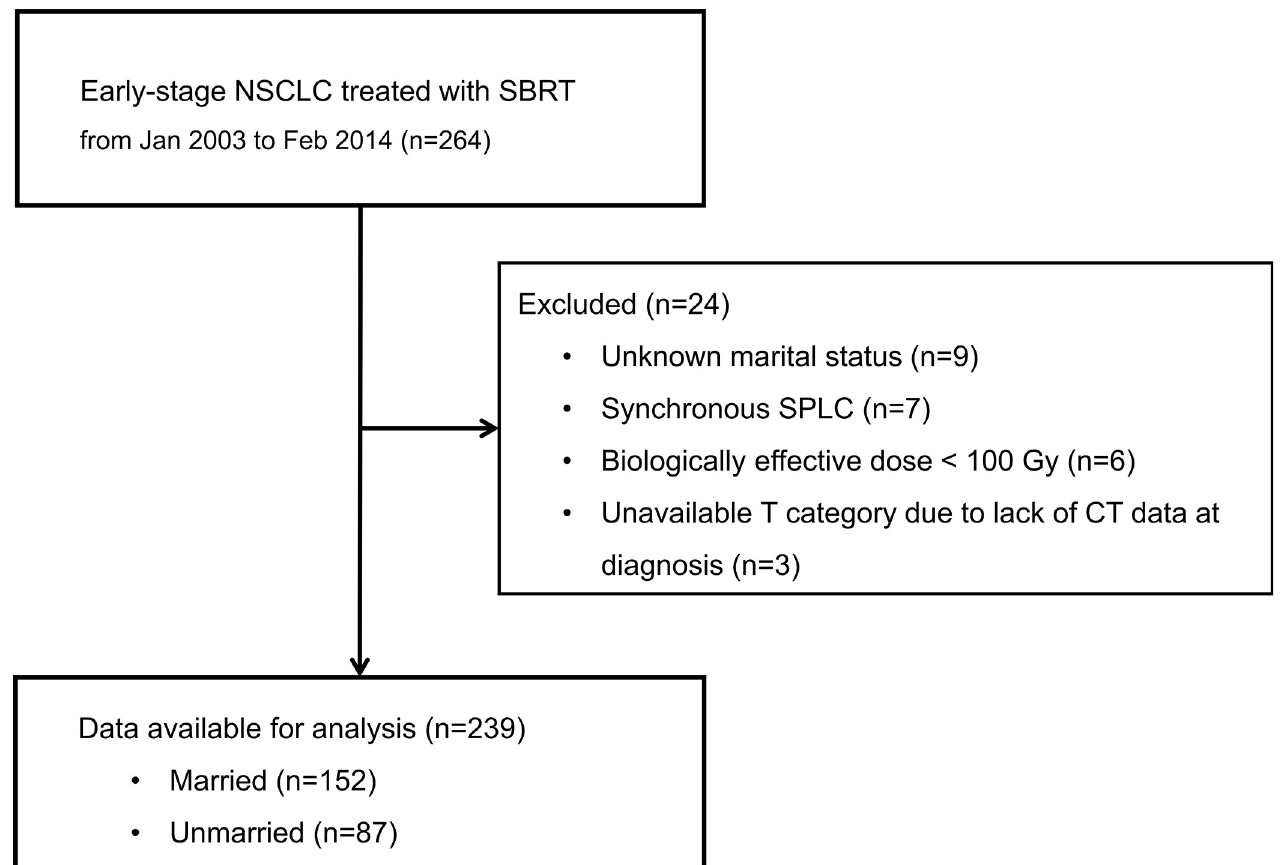
Fig 1. The flow diagram of this